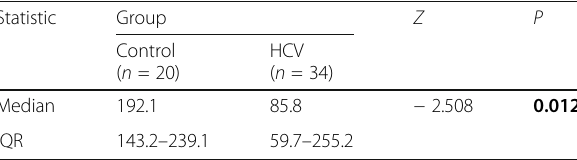
Table 1 ATX level regardless of sex in the 2 groups: it showed a statistically significant higher ATX level in control subjects vs HCV patients